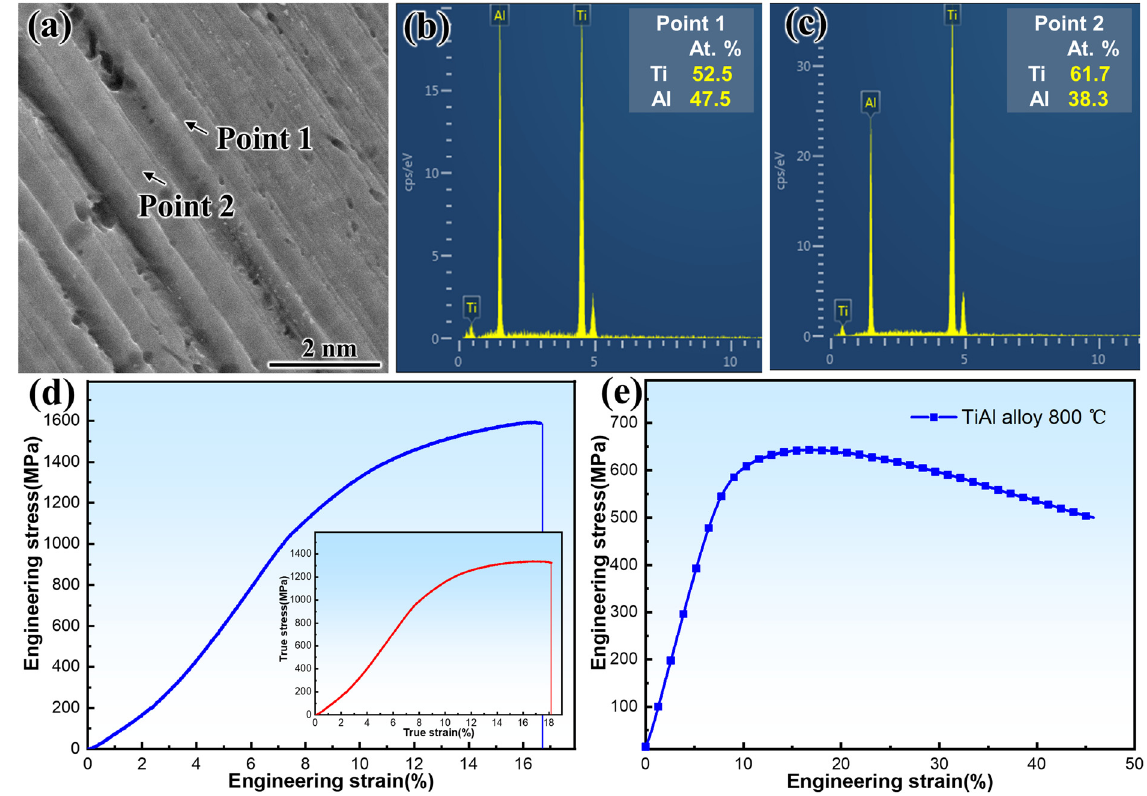
Figure 1: The SEM microstructure and mechanical properties of TiAl alloys: ( a ) SEM image; ( b ) element composition of Point 1 in ( a ) ; ( c ) element composition of Point 2 in ( a ) ; ( d ) room - temperature compressive stress – strain curve; and ( e ) high - temperature compressive stress – strain curve.